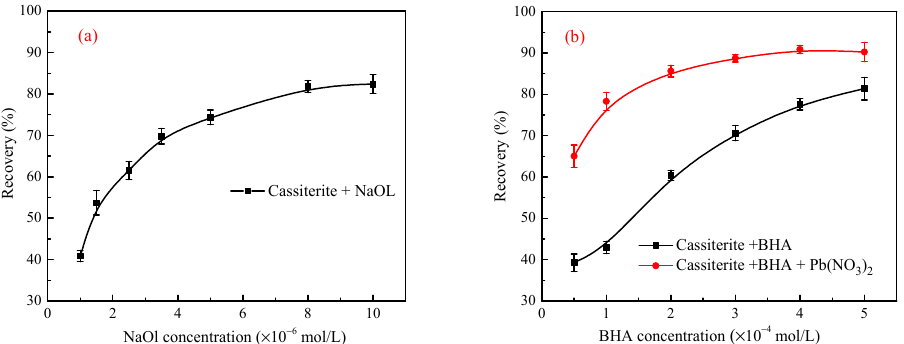
Figure 3. Effect of NaOL ( a ) and BHA ( b ) concentrations on the flotation recovery of − 23 µ m cassiterite (pH = 8.5).